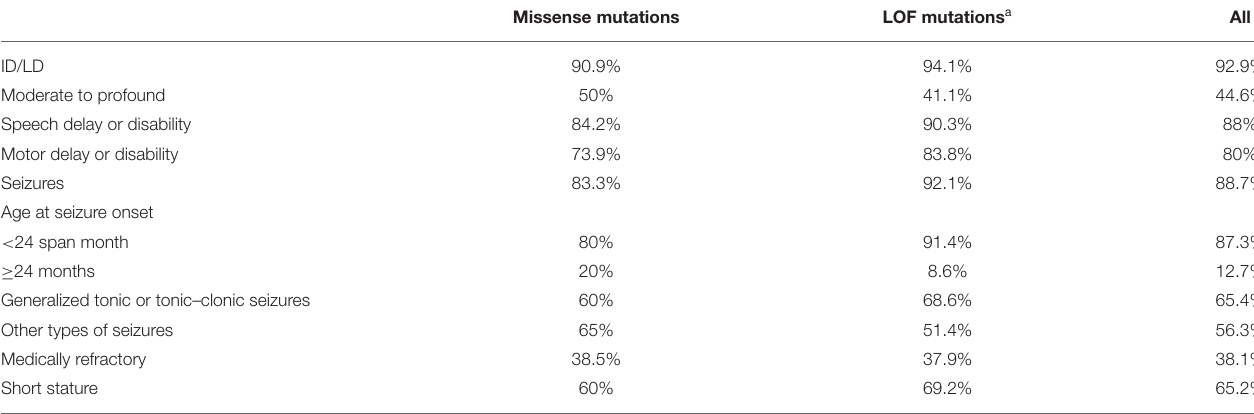
TABLE 3 | Comparison of effects of variant type on clinical manifestations.